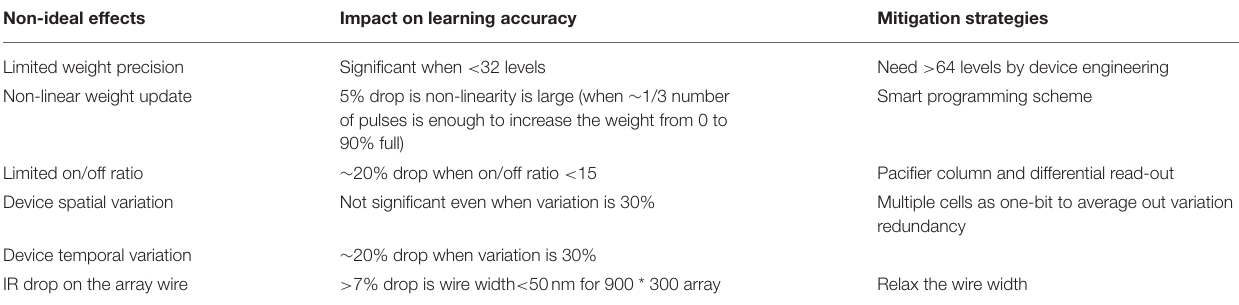
TABLE 4 | Summary of non-ideal effects and mitigation strategies (Adapted from Chen et al.,